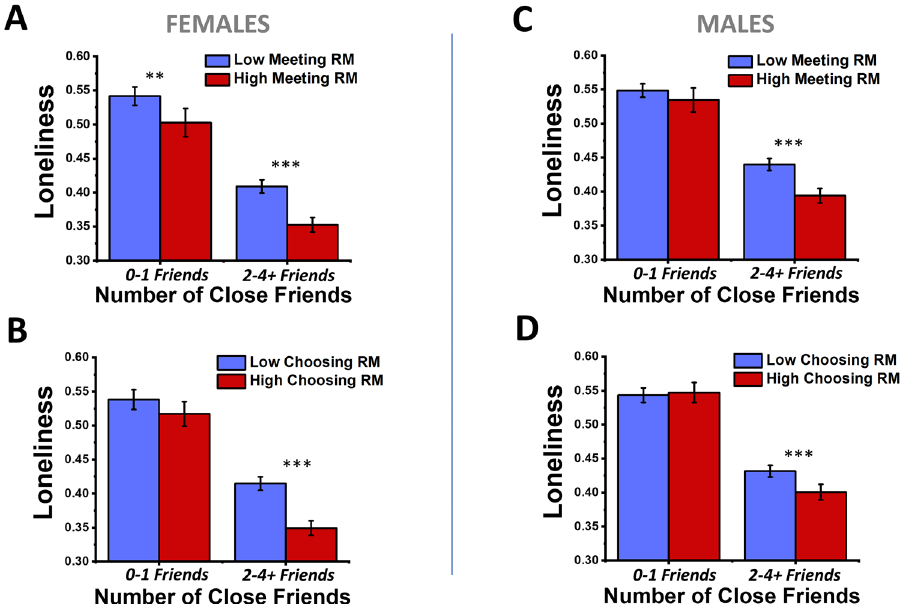
Figure 3. Plots of how perceptions of relational mobility and number of close friends associate in predicting loneliness for males and females. For females ( A , B ) versus males ( C , D ), and the meeting type of relational mobility ( A , C ) and choosing type of relational mobility ( B , D ), bar plots are presented showing the mean loneliness for major sub-populations of subjects that have either 0–1 close friends or 2–4 + close friends, then further divided into subjects that have either lower (blue) or higher (red) perceptions of relational mobility than the average relational mobility value (continuous scores) reported across the entire survey sample. Within each bar plot, for each number-of-close-friends options, two-way ANOVA followed by Bonferroni-corrected pairwise tests were used to identify whether higher and lower relational mobility sub-groupings had significantly different means within each sub-population. For the pairwise tests within each number-of-close-friends category, labels were: * p < 0.05, ** p < 0.01, ***, p < 0.001. Loneliness scores are the continuous raw scores normalized by the max value of 30. Error bars are 95% confidence